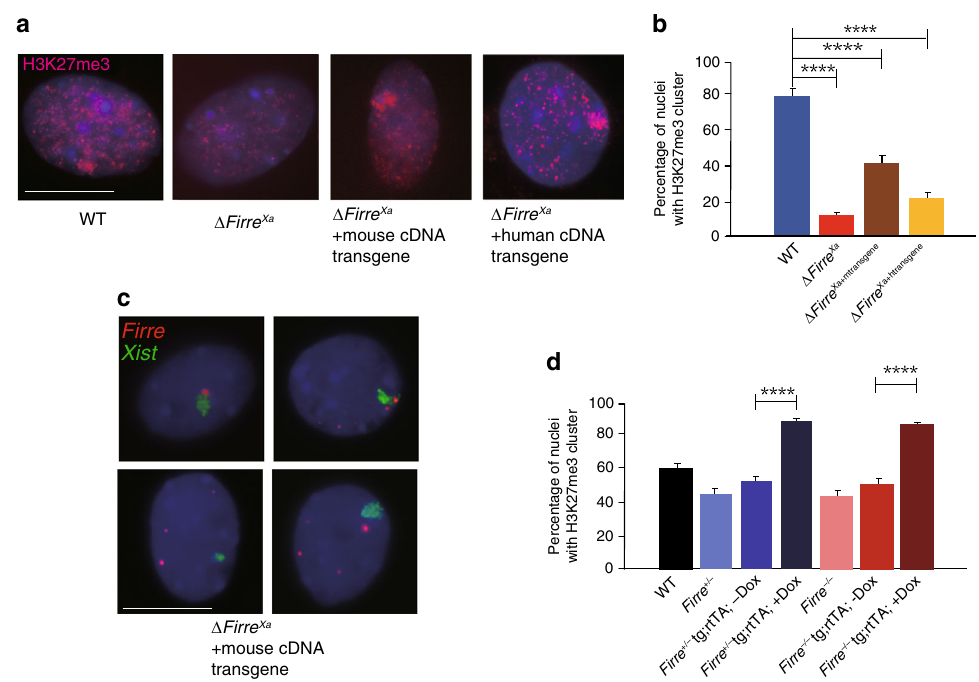
Fig. 4 Ectopic expression of Firre/FIRRE RNA partially restore H3K27me3 on the Xi. a Examples of nuclei after H3K27me3 immunostaining (red) and Hoechst 33342 staining (blue) in WT, Δ Firre Xa , and Δ Firre Xa transfected with a mouse Firre transgene ( Δ Firre Xa + mtransgene ) or a human FIRRE transgene ( Δ Firre Xa + htransgene ). b The bar plot shows a signi fi cantly higher percentage of nuclei with a H3K27me3 cluster in cells with a mouse or human Firre/FIRRE transgene, compared to Δ Firre Xa ( p value = 2.8075e-16 and 0.0000134599, respectively). c Examples of nuclei after RNA-FISH for Xist (green) and Firre (red) in a Δ Firre Xa + mtransgene cell clone with high expression of the mouse transgene. The upper two nuclei show association between Firre and Xist signals (seen in 15% of nuclei), and the lower nuclei, lack of association. d The bar plot shows the percentage of nuclei with a H3K27me3 cluster in MEFs derived from Firre + / − and Firre − / − females that harbor a doxycycline (Dox) inducible transgene ( Firre + / − tg;rtTA; -Dox; Firre + / − tg;rtTA; + Dox; Firre − / − tg;rtTA; -Dox; Firre − / − tg;rtTA; + Dox), compared to WT and mutants. The percentage of nuclei with a H3K27me3 cluster increases signi fi cantly in Firre + / − tg;rtTA and Firre − / − tg;rtTA MEFs after addition of doxycycline (Dox + ) (p value = 4.31567e-30 and 3.51193e-20, respectively). A total of >300 nuclei scored for the presence of a H3K27me3 cluster ( a , b, d ), or for Xist and Firre RNA-FISH signals ( c ) per cell type over three independent experiments; signi fi cance was determined by one-sided Fisher exact test; bar plots are presented as mean values ± SEM; scale bars represent 10 µ